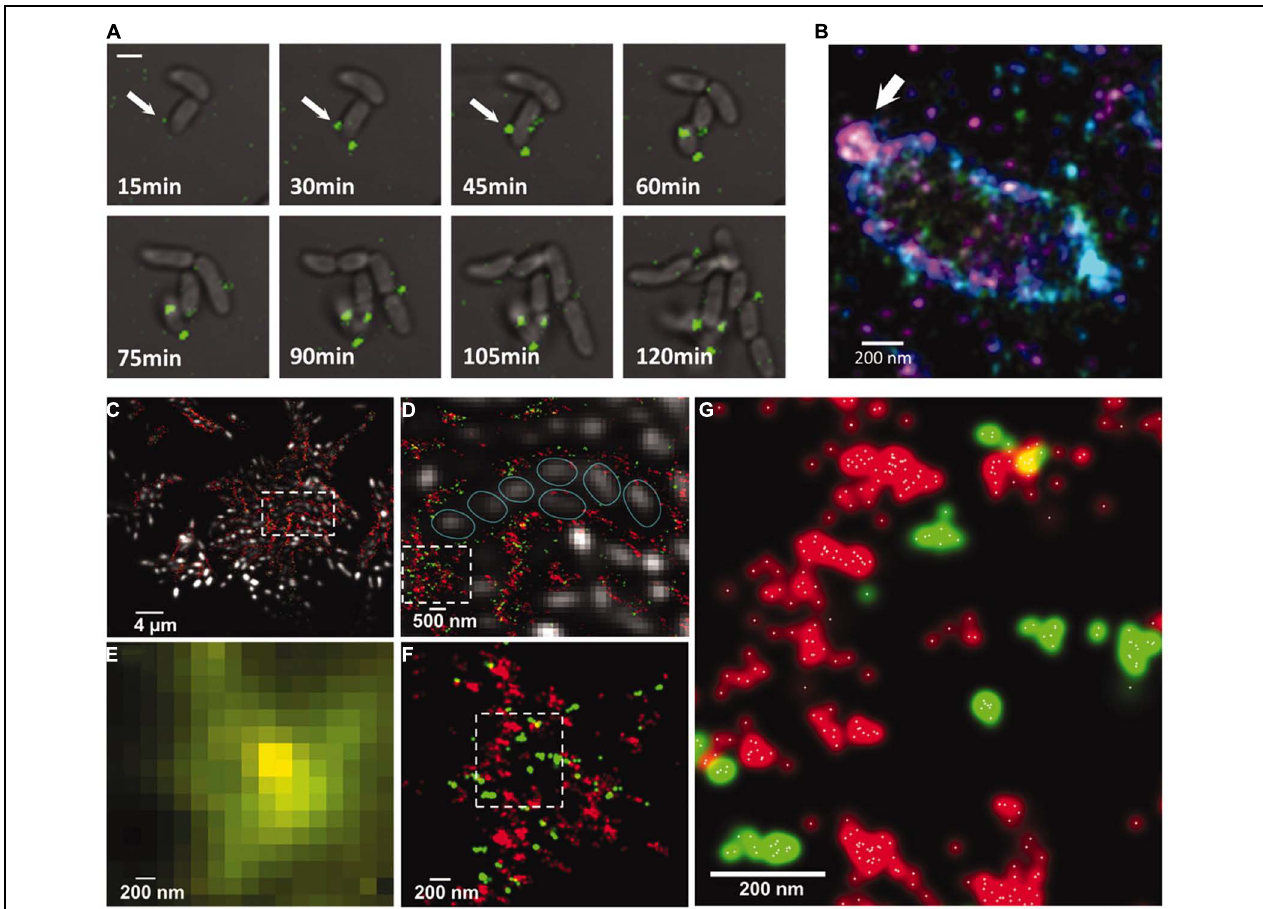
FIGURE 5 | (A) Sectretion of Vibrio polysaccharide (VPS) stained with Cy3 attached to wheat germ agglutinin (green). (B) 3D STORM superresolution image of a single cell showing sectretion of VPS around a single cell. The color represents height in the z -direction. (C–F) Multicolor microscopy images of VPS (red) and RbmC (green). (C,D,F) are STORM superresolution images